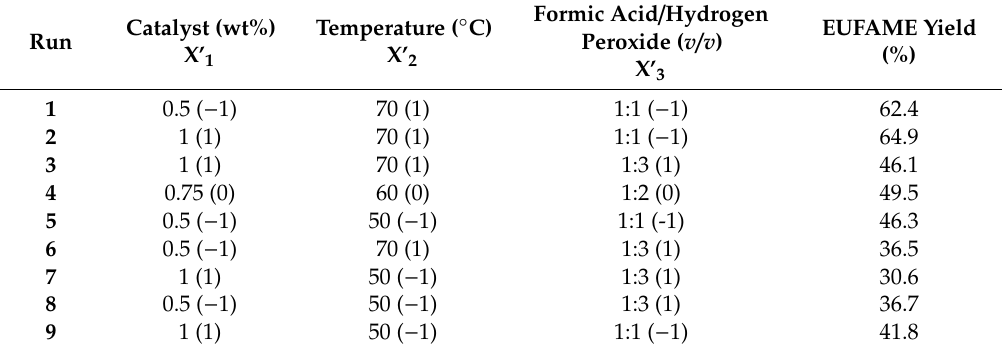
Table 2. Experimental design of the e ff ects of independent variables on the EUFAME